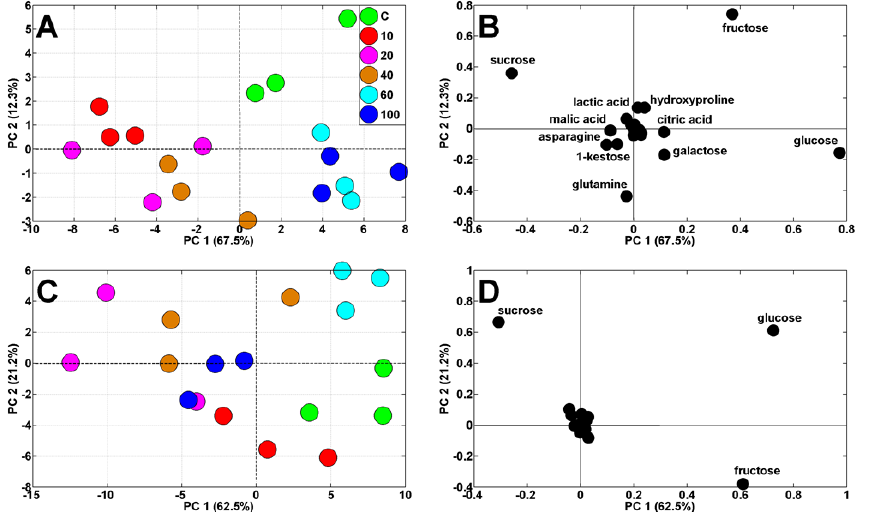
Figure 6. Principal components analysis (PCA) profiles of roots ( A ) and coleoptile ( C ) metabolites of wheat seedlings developing in dd water (control, C ) and citrate-stabilized Ag NPs with sizes of 10, 20, 40, 60, and 100 nm (at a concentration of 20 mg/L each) and PCA loading plots of the polar metabolites ( B , D